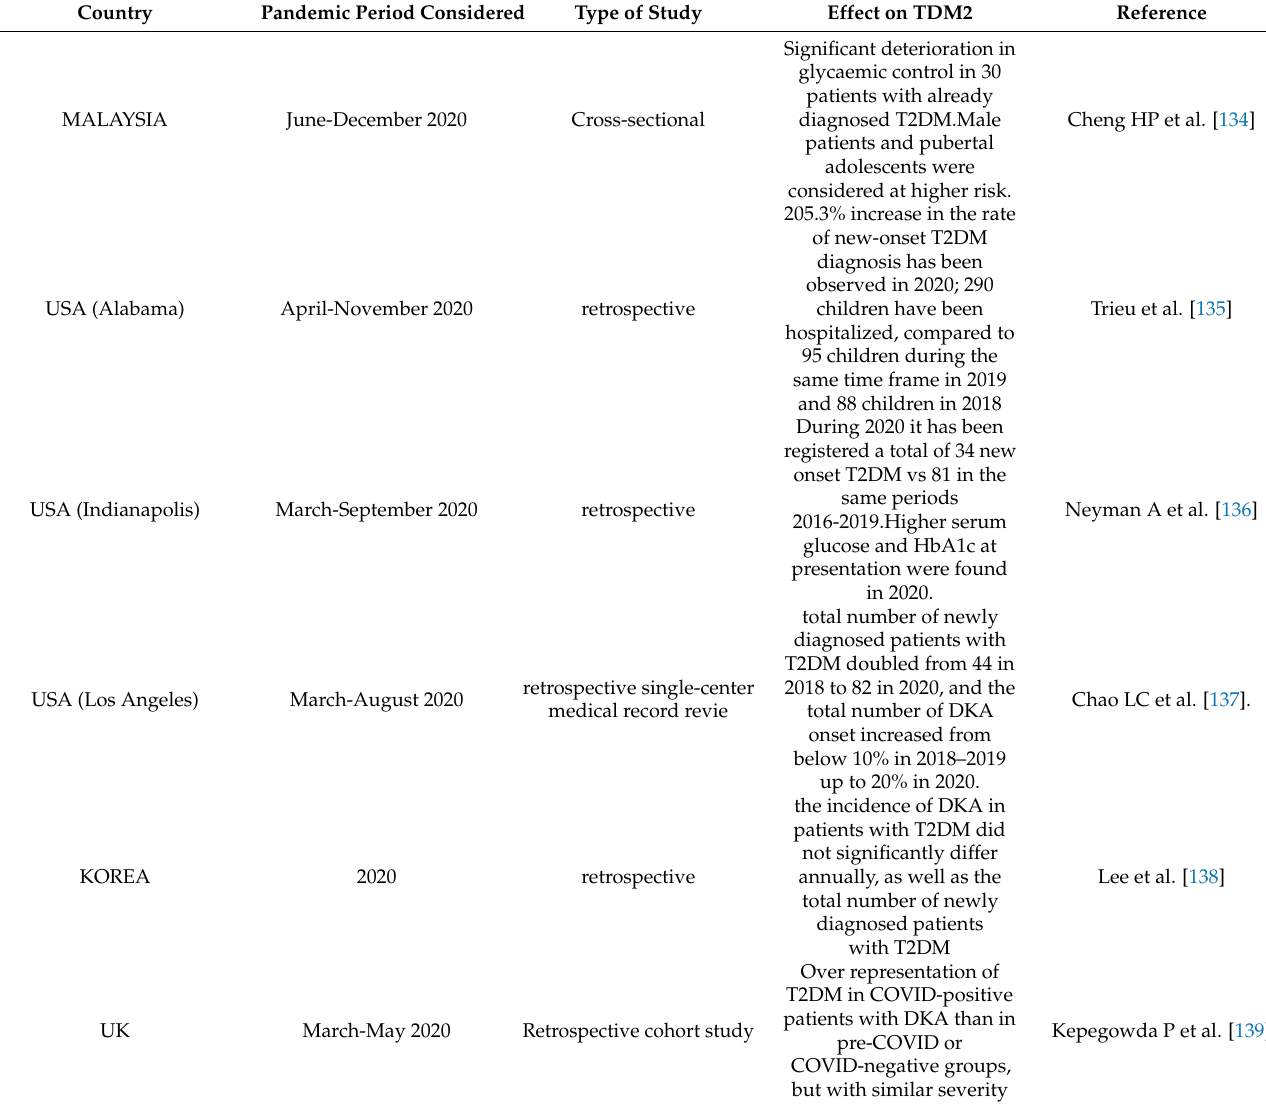
Table 3. The effect of the COVID-19 epidemic on